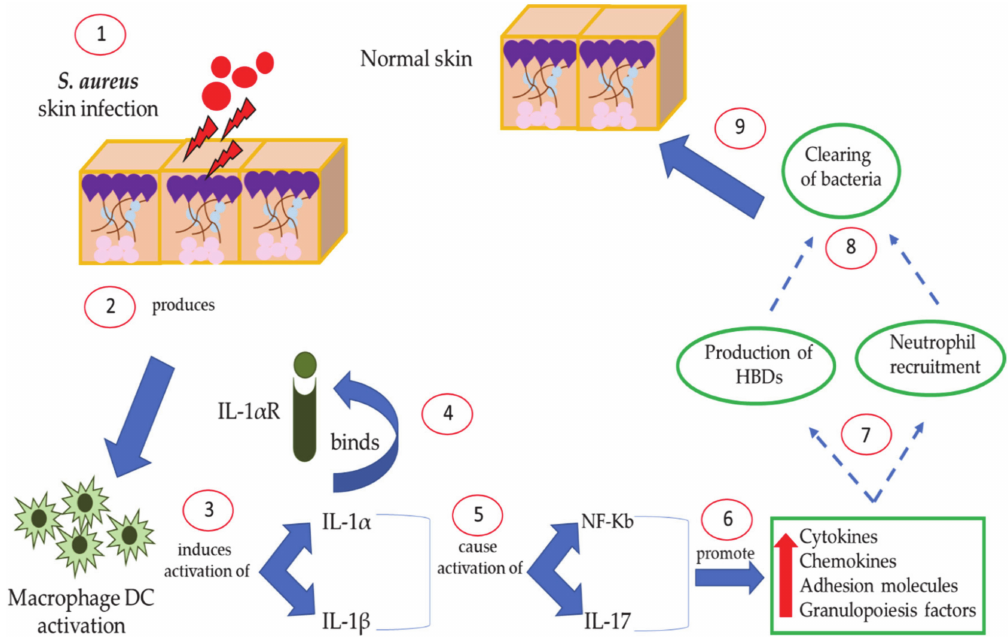
Figure 4. Host defense-mediated human defensins activity against S. aureus skin